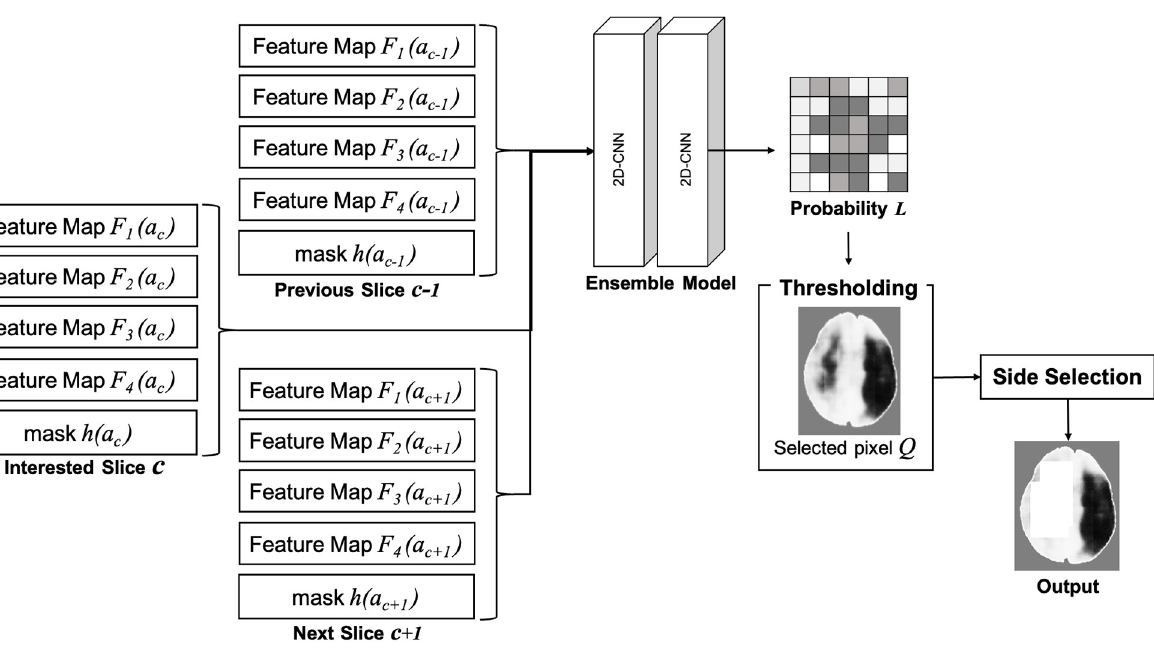
Fig 8. Localizing the infarct region using the extracted feature maps.